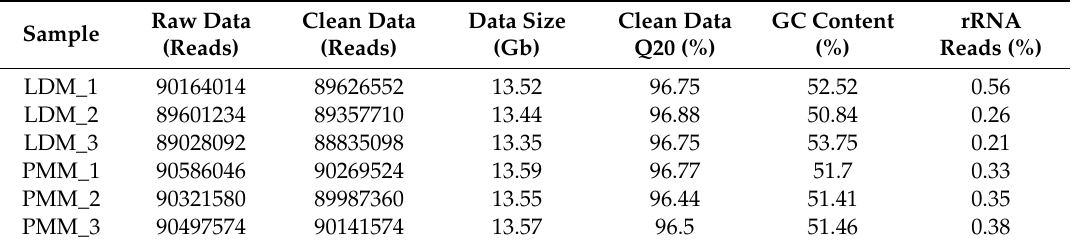
Table 1. Summary of transcriptome